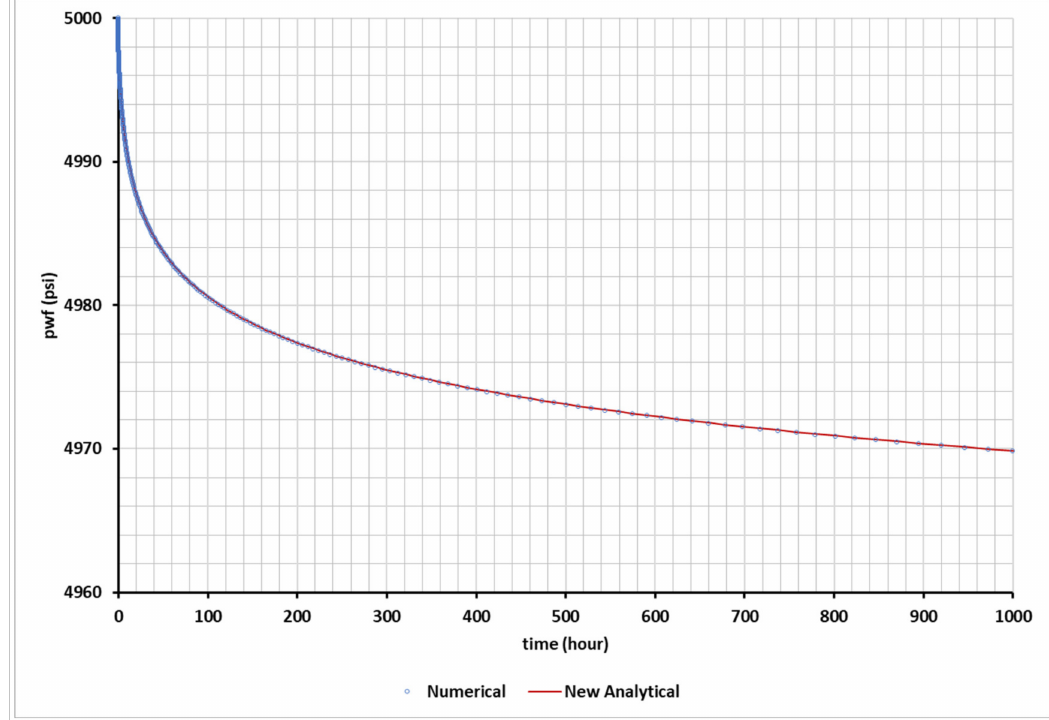
Figure 8. Results Comparison between Analytical Model and Numerical